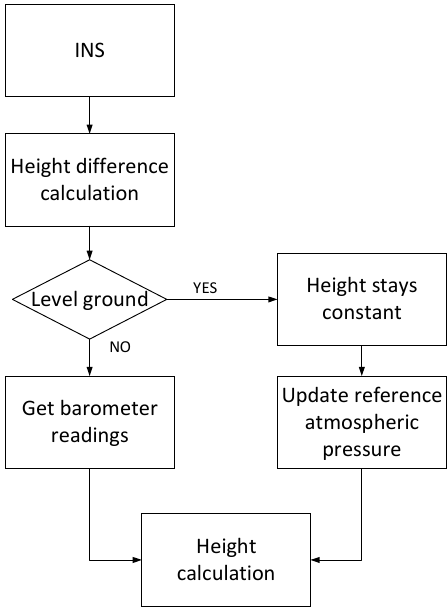
Figure 19 . Flowchart of height difference information aided barometer (HDIB) algorithm. Figure 19. Flowchart of height difference information aided barometer (HDIB)